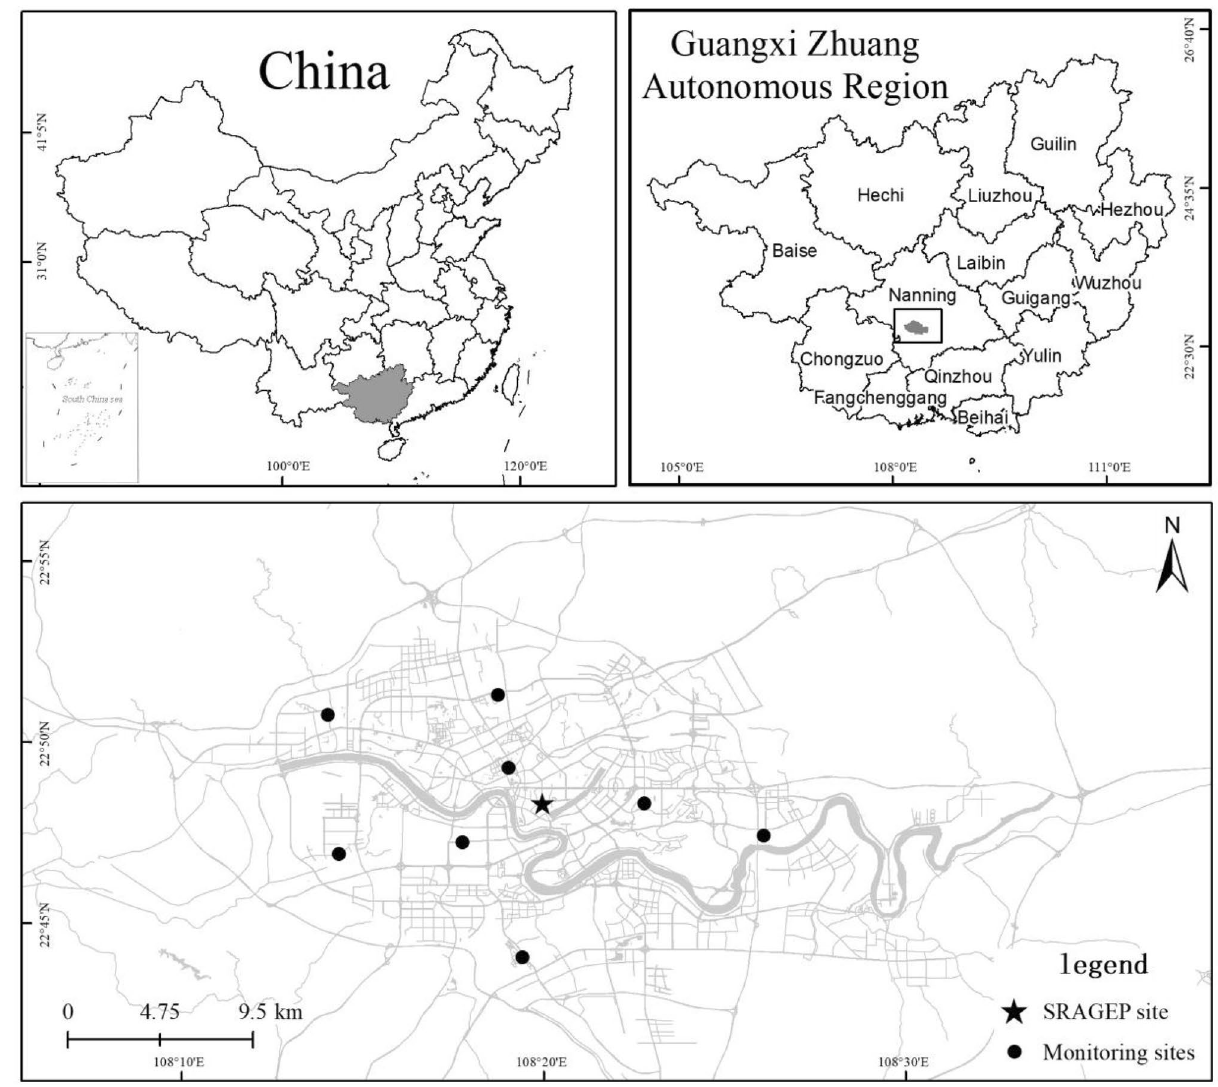
Figure 7. Schematic diagram for the locations of observation stations. The map was generated using ArcGIS Desktop 10.3, https:// deskt op. arcgis. com/